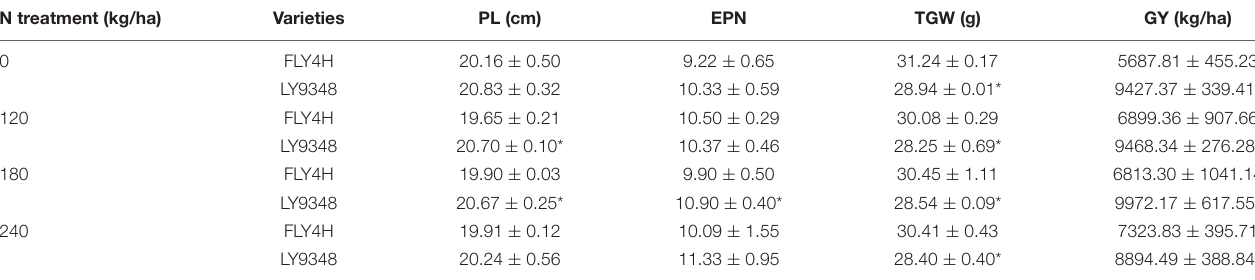
TABLE 3 | The yield traits of FLY4H and LY9348 for different nitrogen treatments. N treatment (kg/ha)